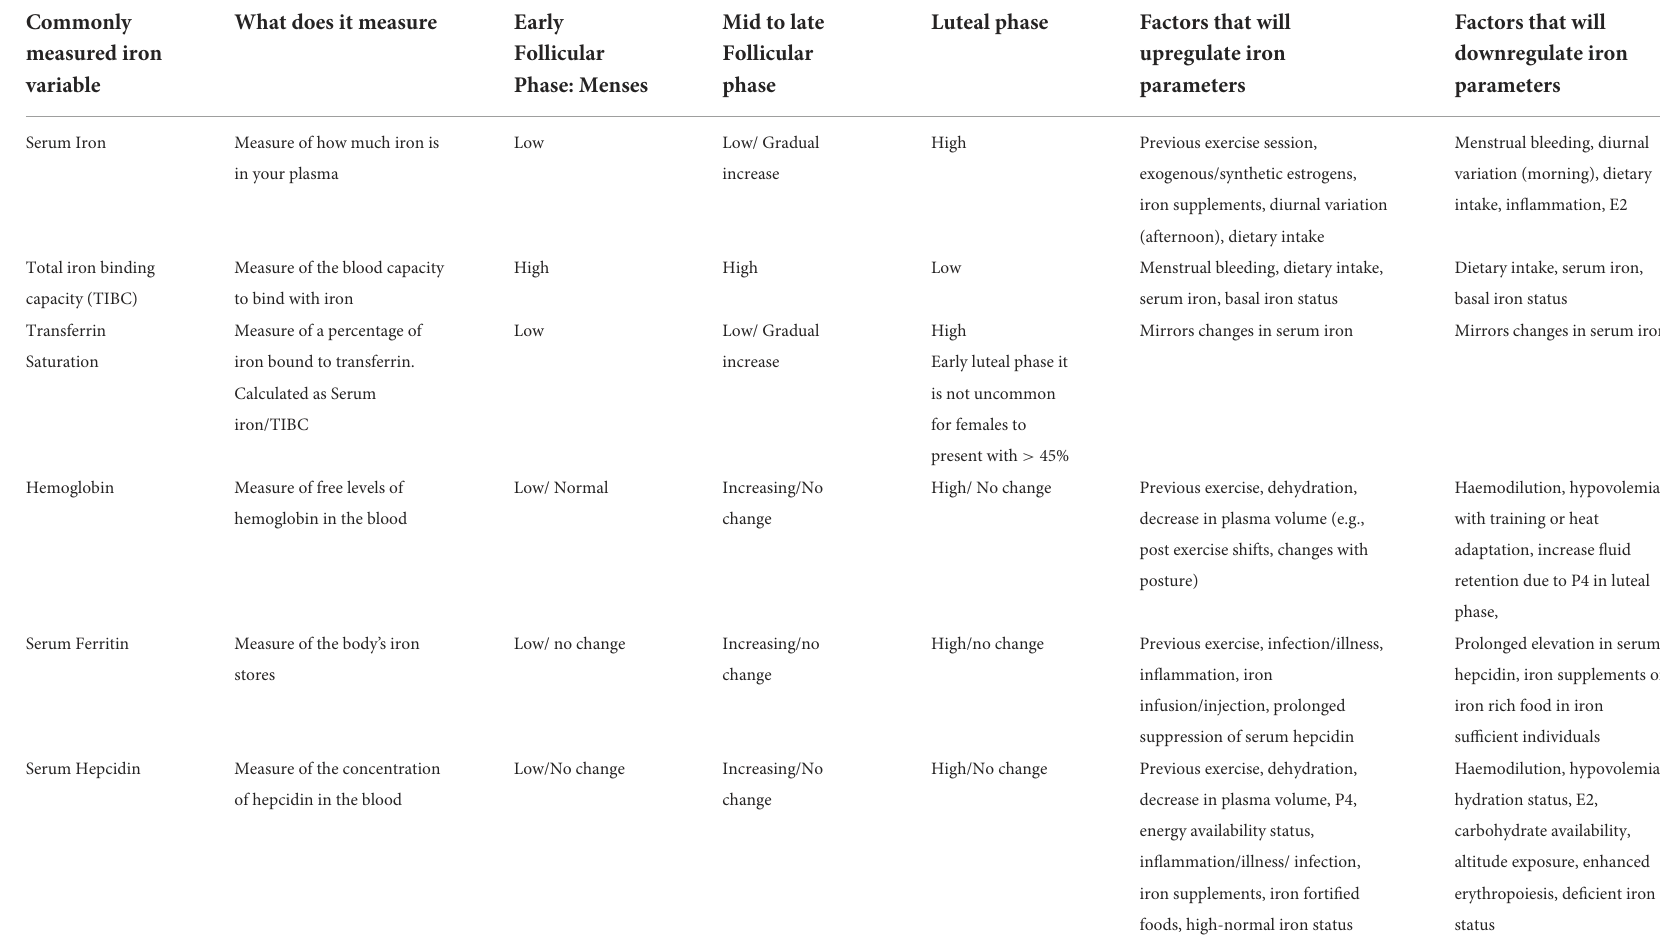
TABLE 5 Expected changes to iron parameters throughout the menstrual cycle in active